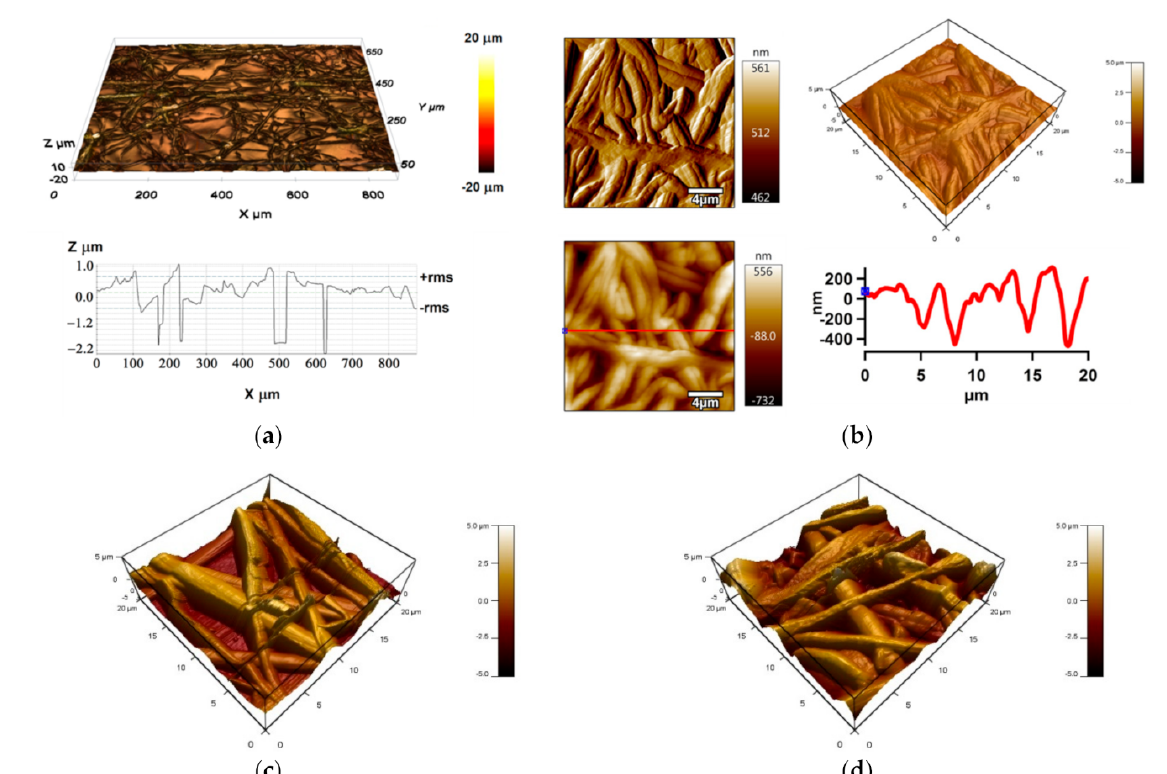
Figure 4. Profilometry image ( a ), AFM images—amplitude and 3D height, and a Z-sensor with line profile of PDMS/PA electrospun fiber mats prepared on aluminum substrate ( b ); and 3D height AFM images of electrospun fiber mats prepared on PE ( c ) and PU ( d )